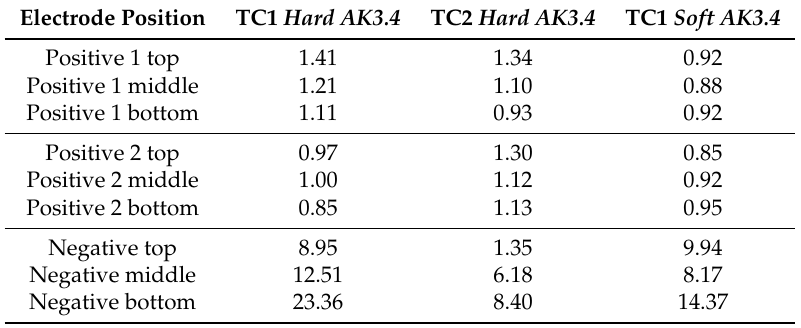
Table 3. Rates on sulfur oxide ( SO 4 ) of negative and positive electrodes at different positions in